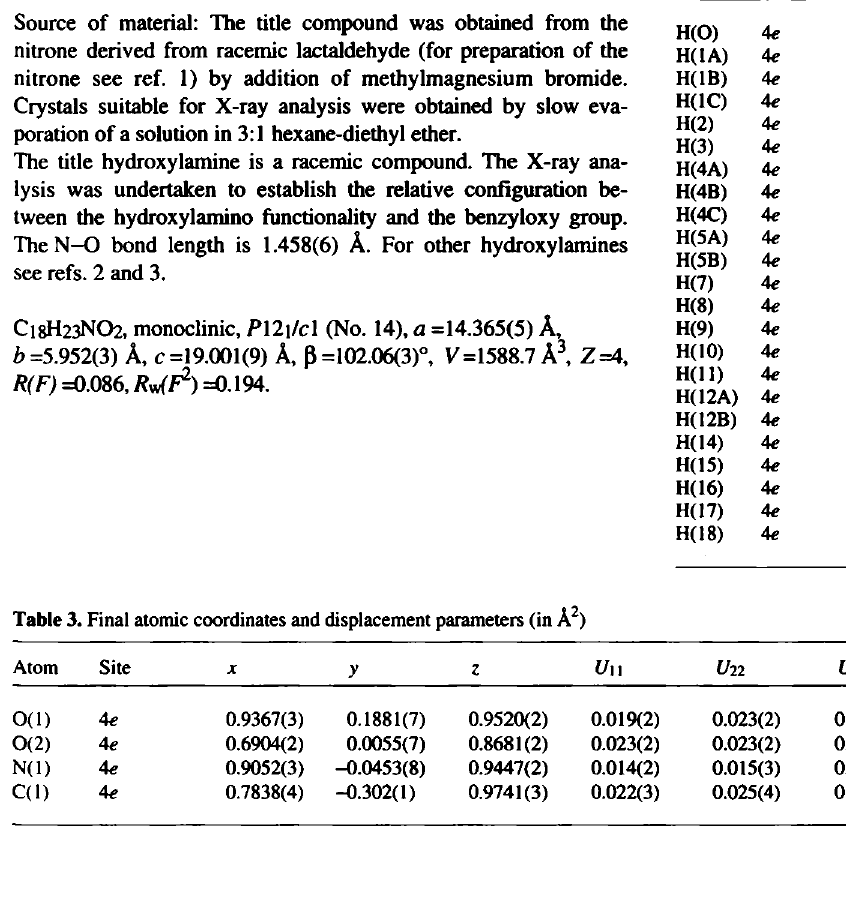
Table 2. Final atomic coordinates and displacement parameters (in Â 2 )